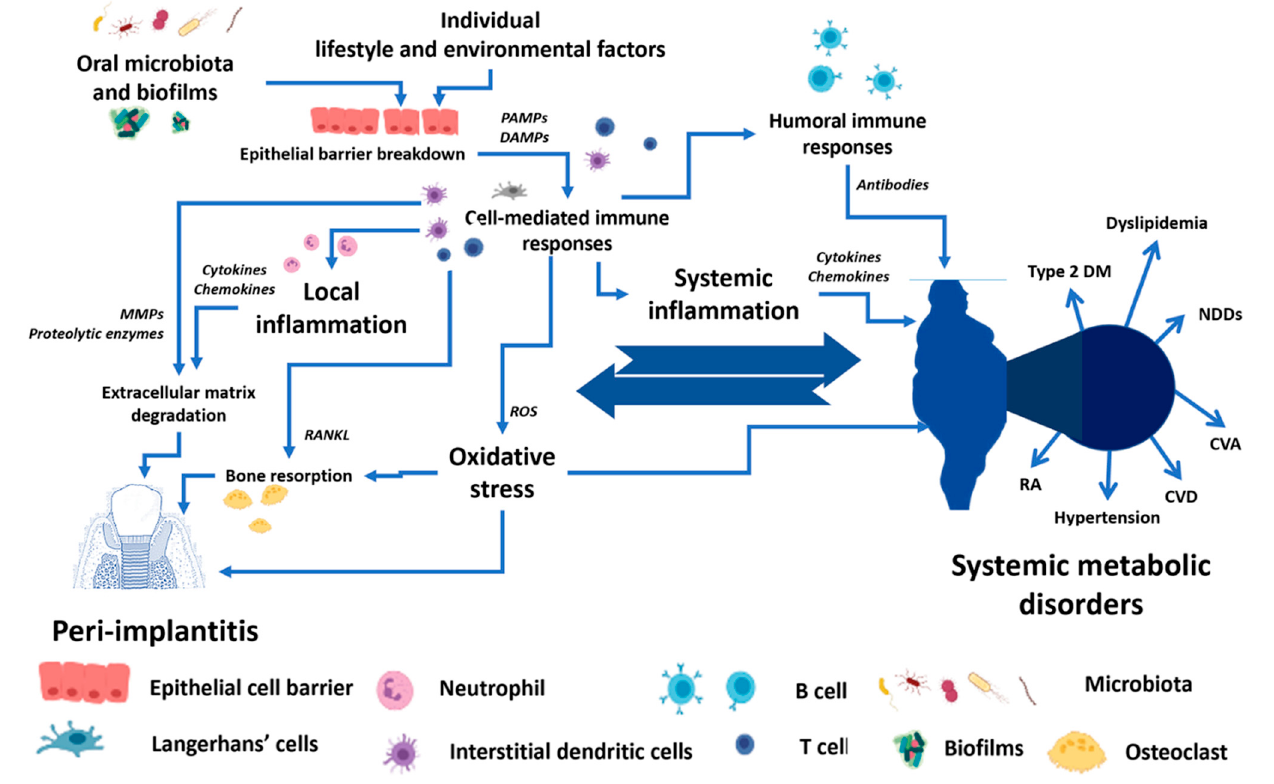
Figure 1. The conceptual framework of the bi-directional relationship between peri-implantitis and systemic metabolic disorders. PAMPs—pathogen-associated molecular patterns, DAMPs—damage-associated molecular patterns, MMPs—matrix metalloproteinases, RANKL—receptor activator of nuclear factor- κ B ligand, ROS—reactive oxygen species, Type 2 DM—type 2 diabetes mellitus, NDDS—neurodegenerative disorders, CVA—cerebrovascular accident, CVD—cardiovascular diseases, RA—rheumatoid arthritis.